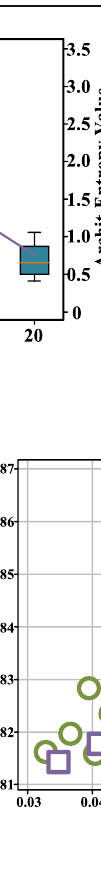
Fig. 11 Example of the number of parameters and validation accuracy of the final architectures searched by AEMONAS and naive